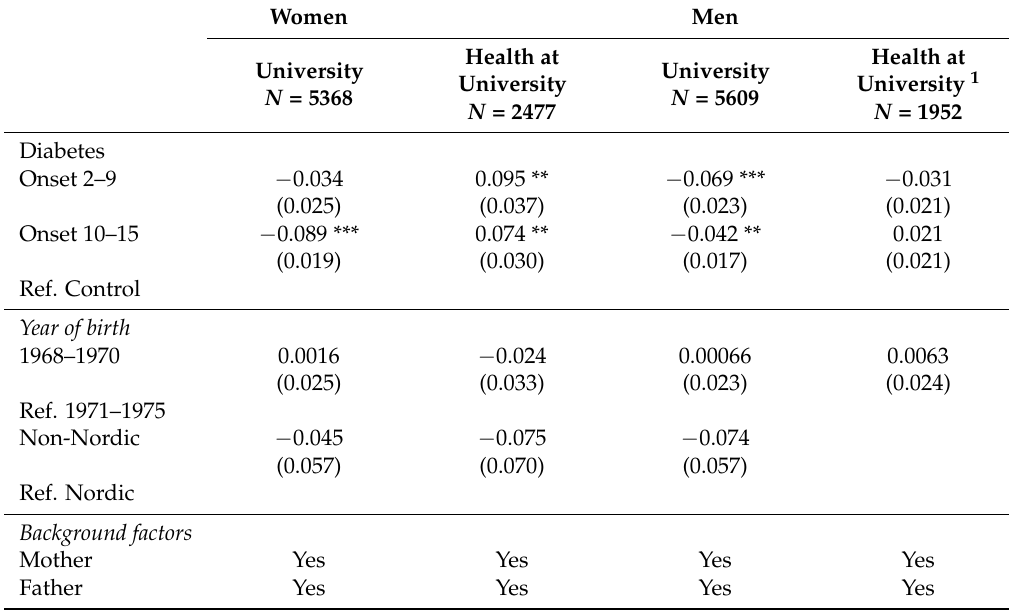
Table 11. Test with two diabetes onset categories: Average marginal effects of the probability of having a university education (Uni) and the probability of having undertaken a health-related university program for those with a university education